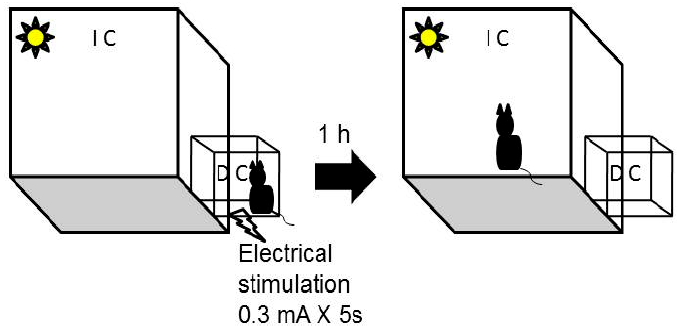
Figure 3. Schematic representation of the passive avoidance task. IC—illuminated chamber. DC—dark chamber.